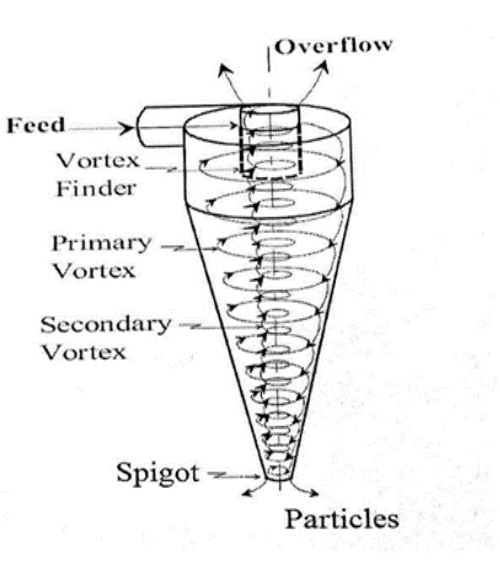
Fig. 1. A type of